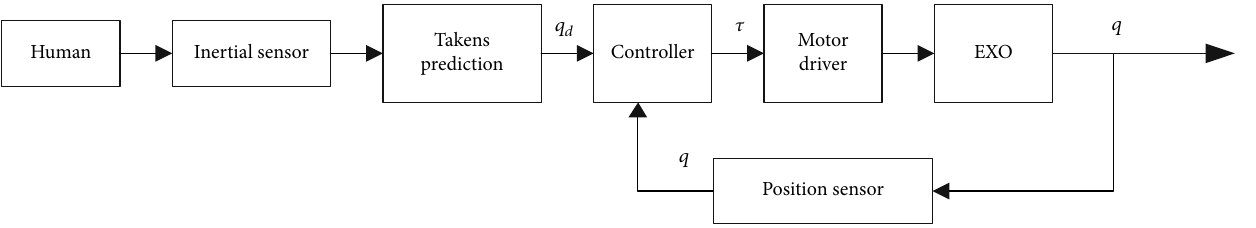
Figure 5: Follow-up control strategy block diagram of the exoskeleton.